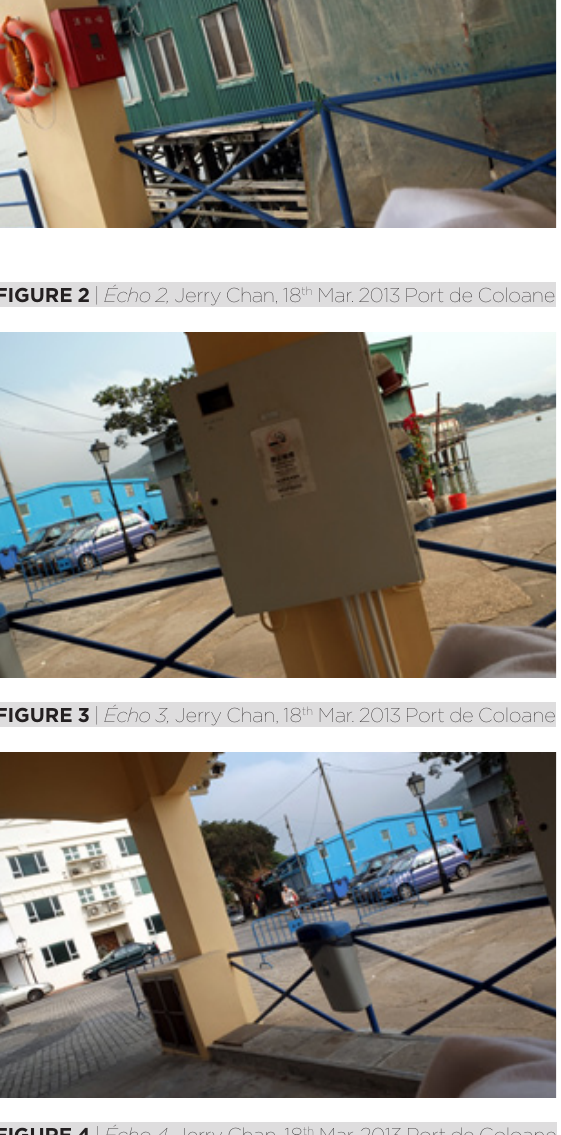
FIGURE 4 | Écho 4, Jerry Chan, 18 th Mar. 2013 Port de Coloane